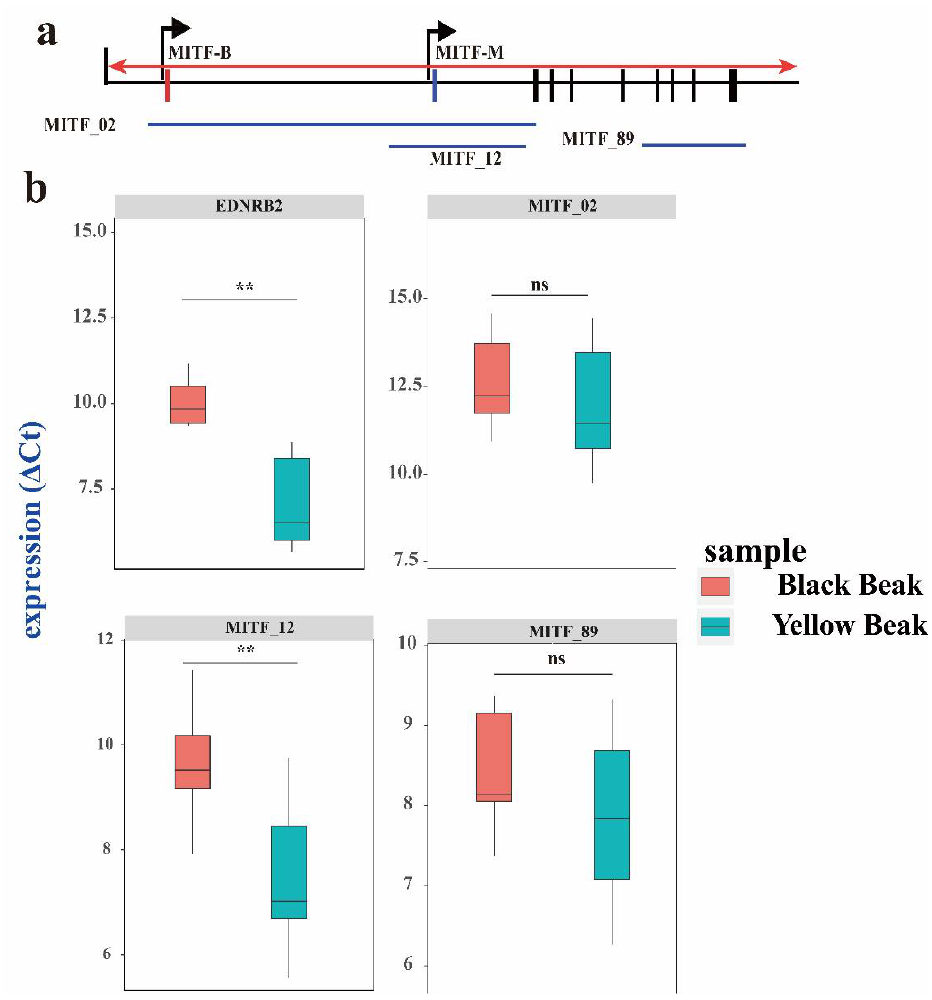
Figure 6. Expression differences in EDNRB2 and MITF on three exon junctions between black and yellow beaks according to RT-qPCR. ( a ) Information on the MITF isoform. The red triangle represents the intronic insertion on chromosome 13 in Pekin ducks. Exon 1M is specific for the MITF-M transcript, while exon 1B is specific for the MITF-B transcript. ( b ) EDNRB2 and MITF on three exon junctions between black and yellow beaks. Each exon junction was assayed in six biological replicates with three technical replicates. The indicated p -values were based on one-way ANOVA. NS, nonsignificant; **, extremely significant.